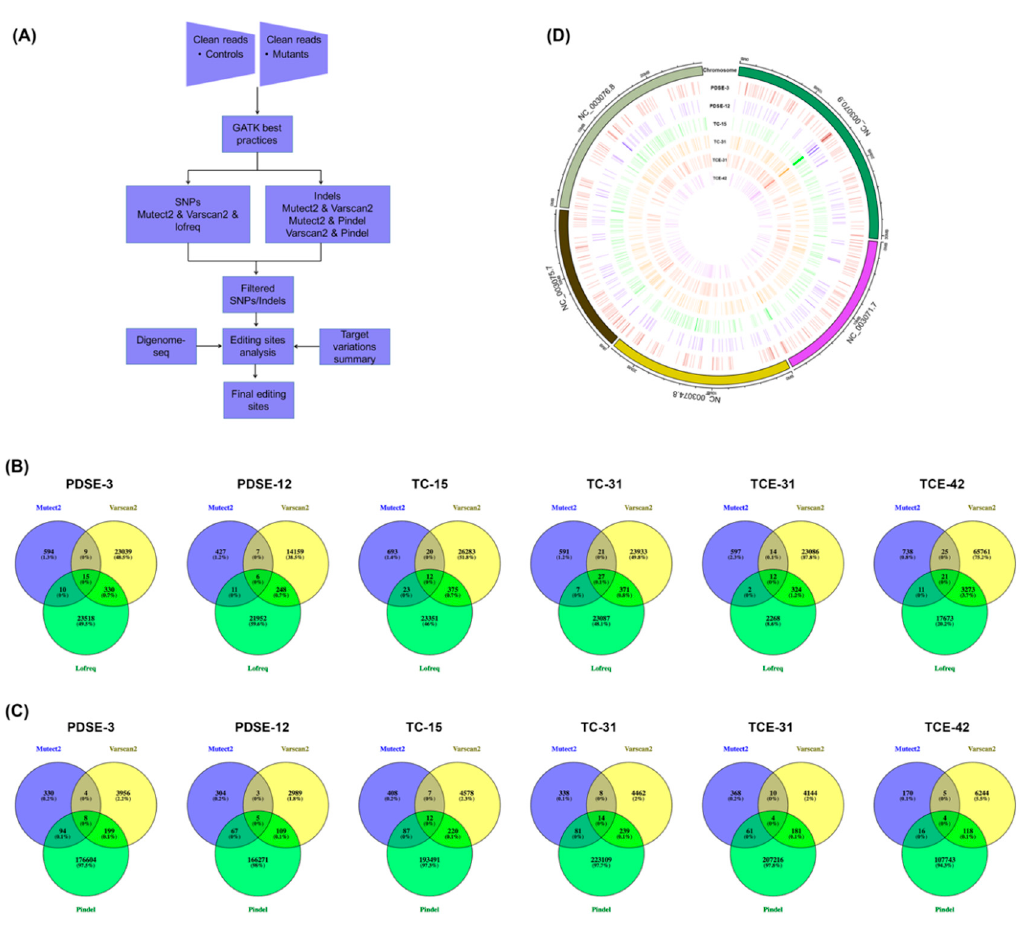
Figure 4. Whole-genome variations analysis in genome-edited mutants. ( A ) Workflow of whole-genome detection of single nucleotide variations (SNVs) and indels. ( B ) Venn diagram of SNVs in genome-edited mutants detected by variant callers. ( C ) Venn diagram of indels in genome-edited mutants detected by variant callers. ( D ) Genome-wide distribution of mutations in CRISPR / Cas9-edited mutants. Table 2. Variations in CRISPR / Cas9-edited mutants.